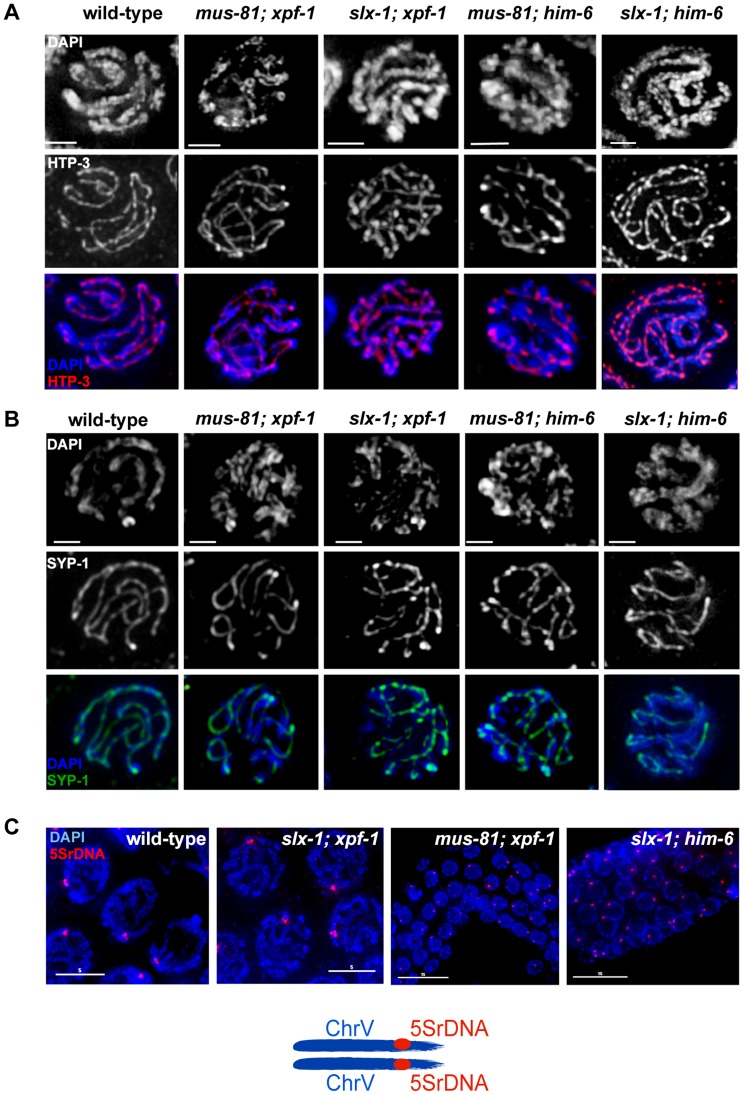
Normal chromosome morphology and HTP-3 and SYP-1 loading in pachytene stage nuclei in [mus-81; xpf-1], [slx-1; xpf-1], [mus-81; him-6] and [slx-1; him-6] double mutants.(A) Projections of representative nuclei from whole-mount gonads stained with α-HTP-3 antibody (white) and DAPI (white), or red and blue, respectively, in merged images. (B) Representative pachytene nuclei stained with α-SYP-1 antibody and DAPI (SPY-1, green in merged images). Scale bars are shown in white (1 µm). (C) FISH images were taken with 100× and 60× magnification.